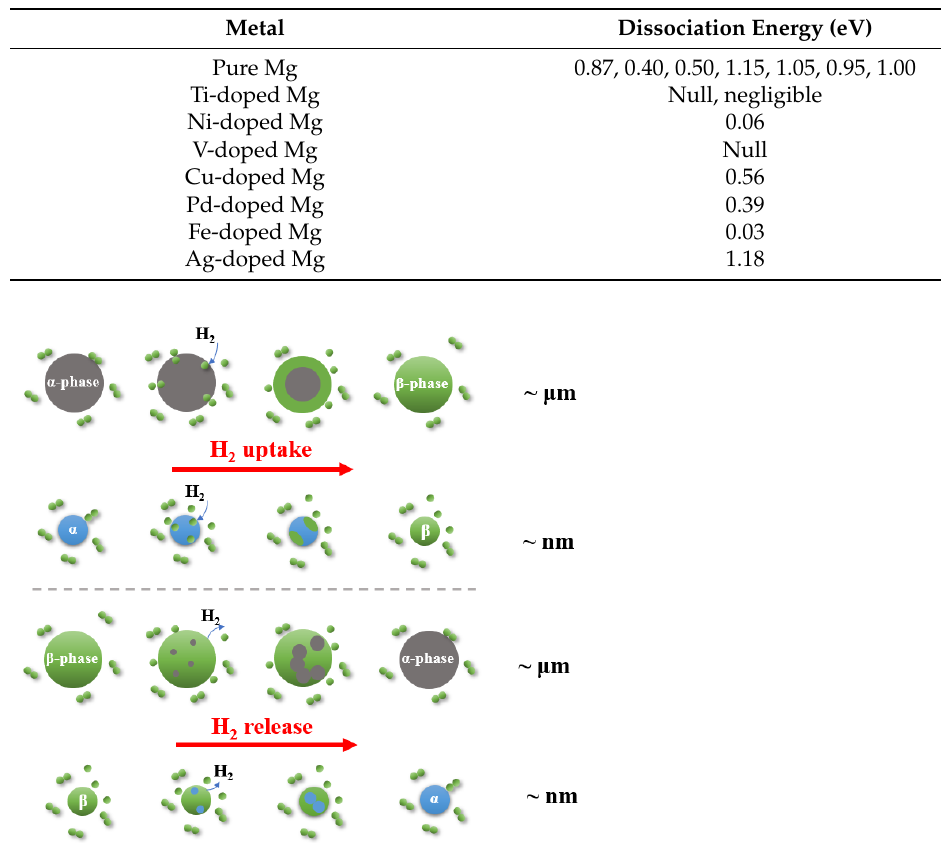
Table 3. Dissociation energy of hydrogen molecule on the surface of Mg. (Reproduced with permis- sion from ref. [49]. Copyright 2008 AIP Publishing).